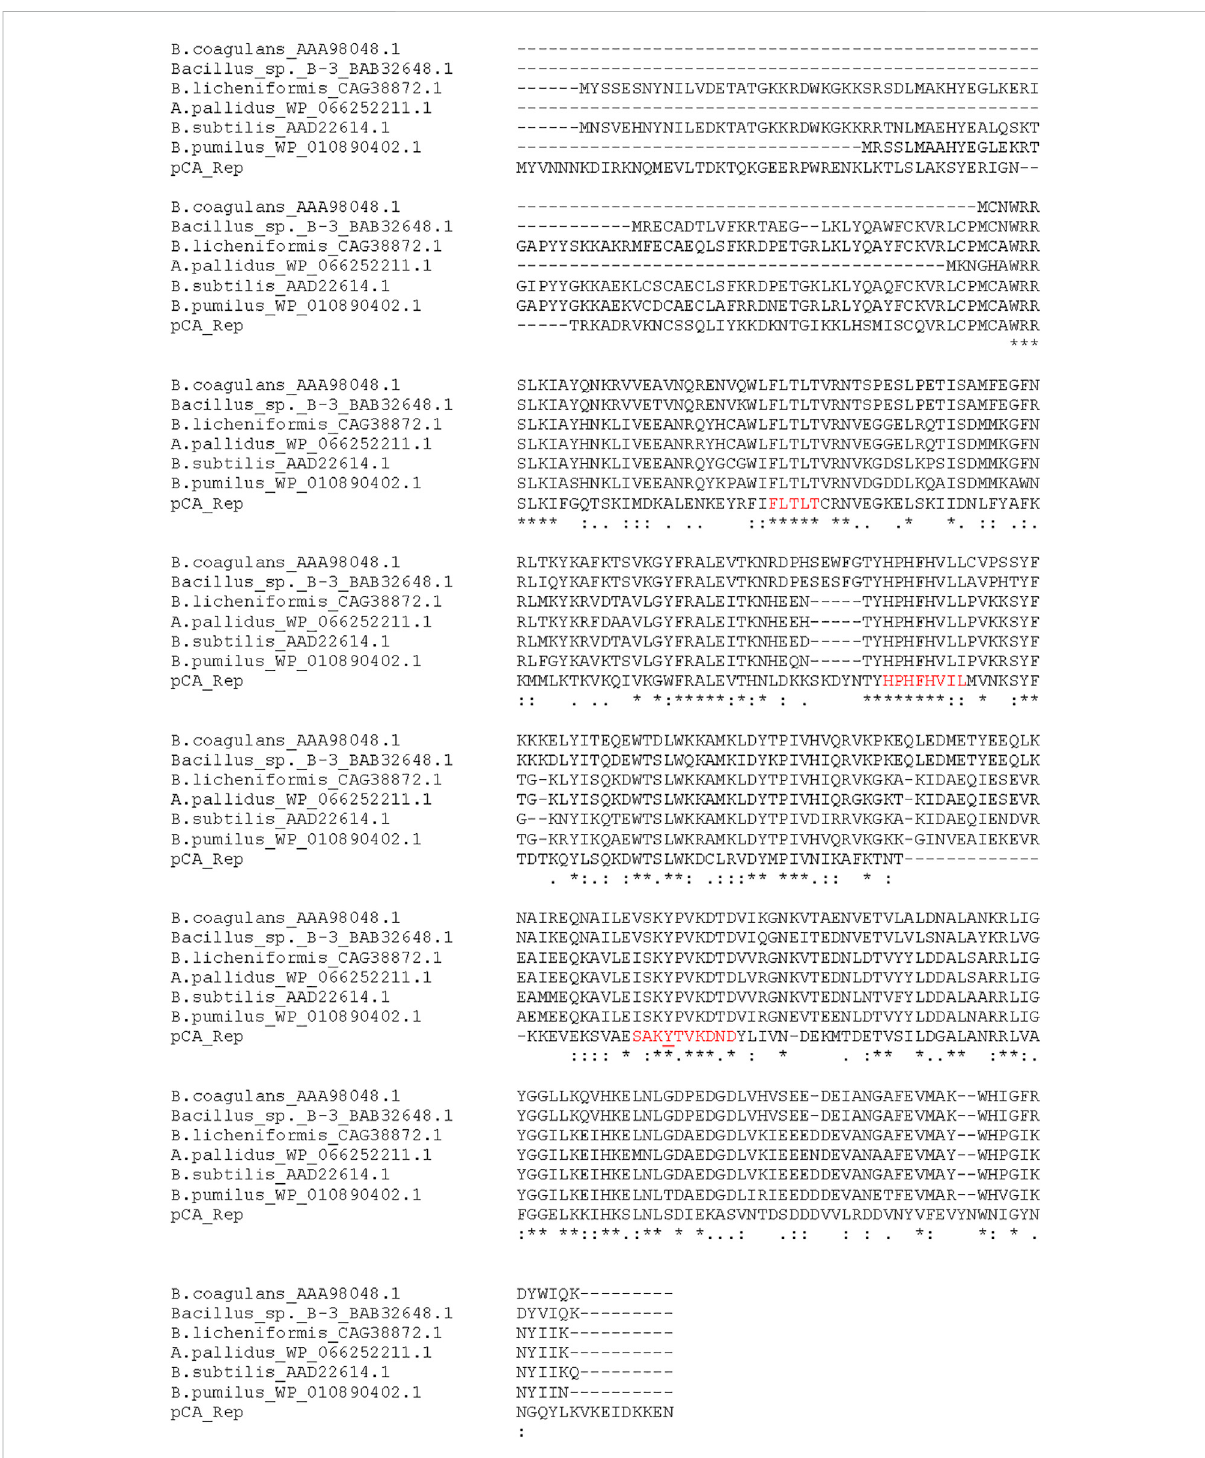
FIGURE 3 pUB110/pMV158-like replication protein in pCA. Replication protein sequences from Bacillus species and Rep protein from pCA (pCA-Rep) were aligned using ClustalW. The conserved regions are highlighted in red and the putative active site tyrosine residue is